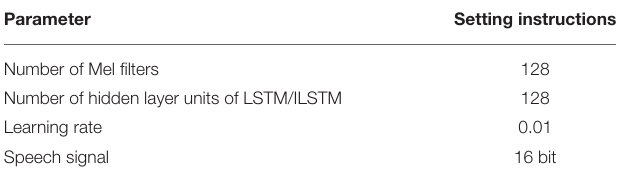
TABLE 2 | Experimental parameter